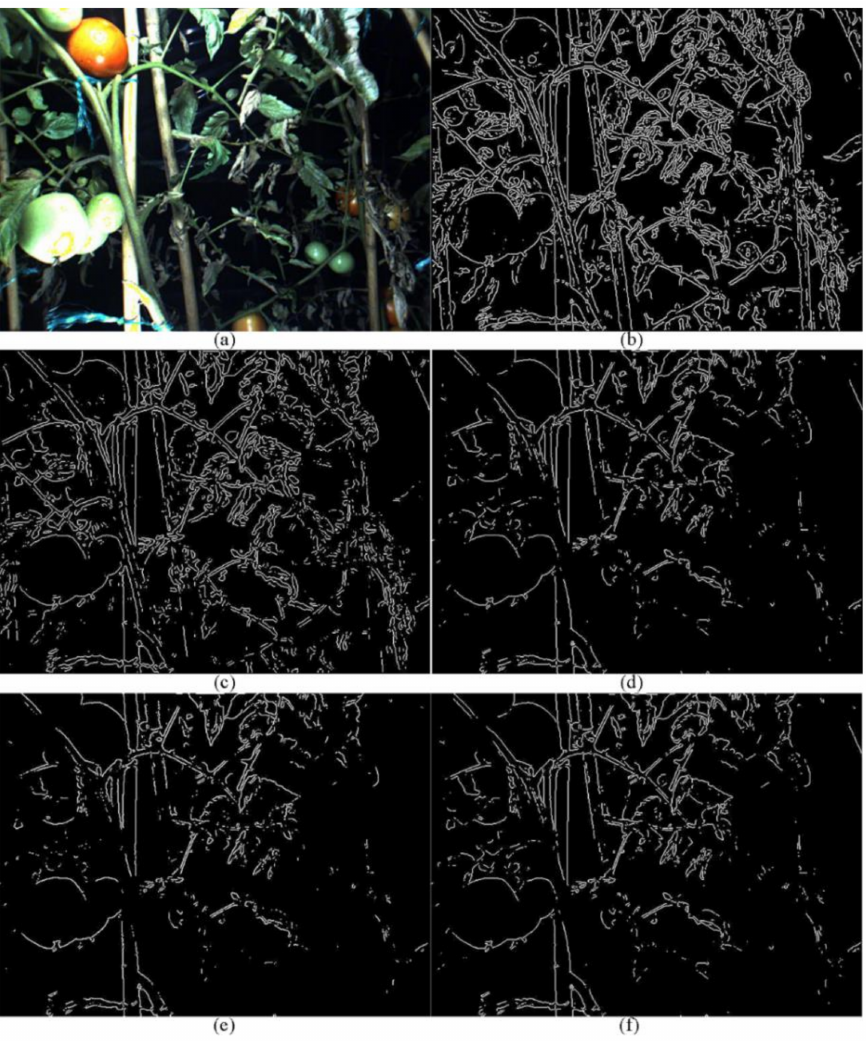
Figure A2. Edges extracted by five operators: ( a ) raw image; ( b ) Canny operator; ( c ) LOG operator; ( d ) Prewitt operator; ( e ) Roberts operator; ( f ) Sobel operator.